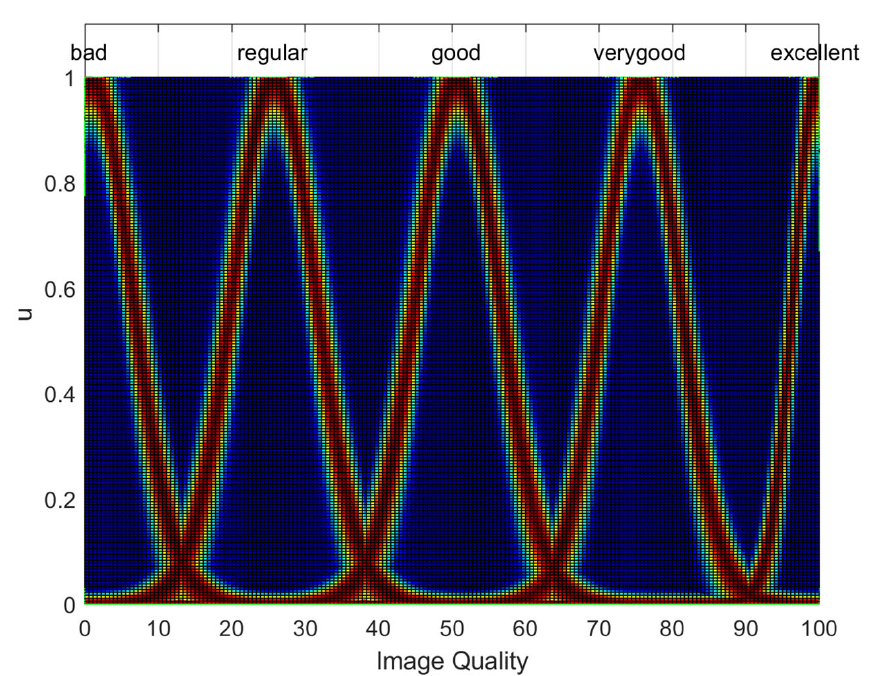
Figure 4. Nonmembership functions of the output variable.